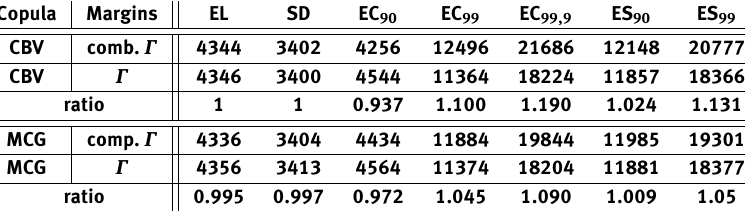
Table 6. Impact of marginal sector distribution on risk